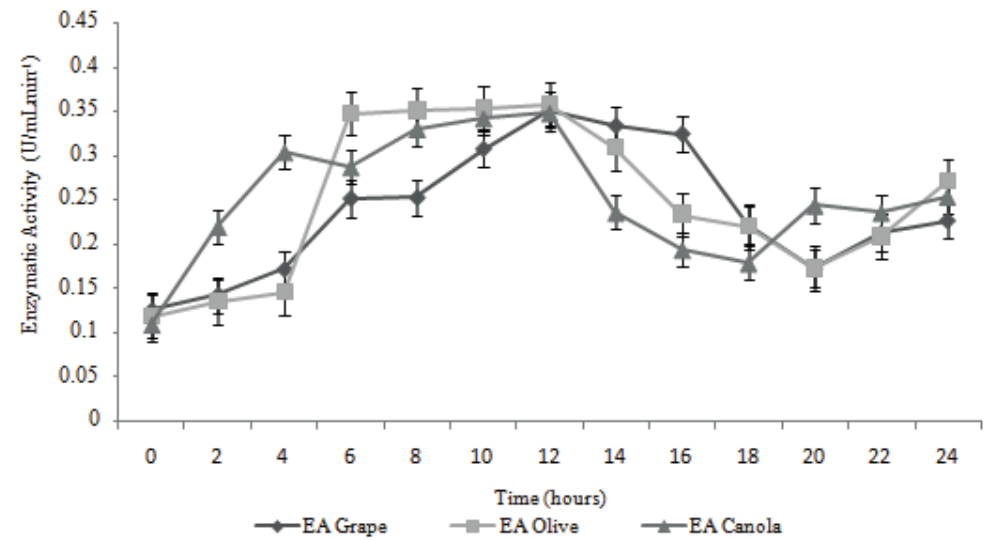
Figure 3 - Enzymatic activity produced by isolate G40 using olive oil, grape seed oil, and canola oil as the main carbon source, with Tween 80. Experiment performed in the bioreactor at 30 °C, agitation fixed at 300 rpm, aeration rate of 1.5 vvm, for 24